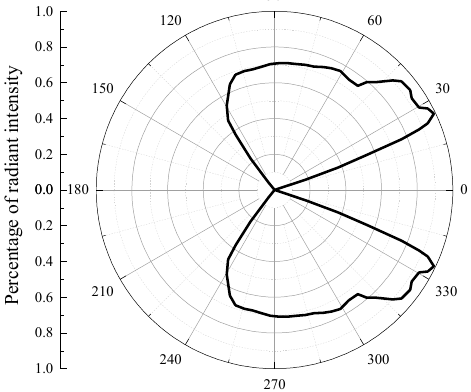
Figure 2. Polar angular radiative flux distribution for Osram XBO 4000 W HS OFR.